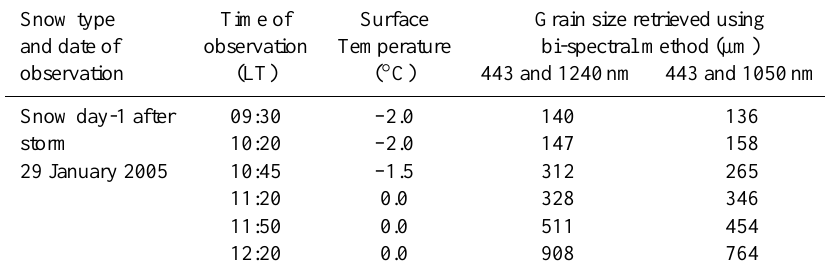
Table 6. Snow grain size retrieved using field spectroradiometer in lower Himalayan area. Snow type Time